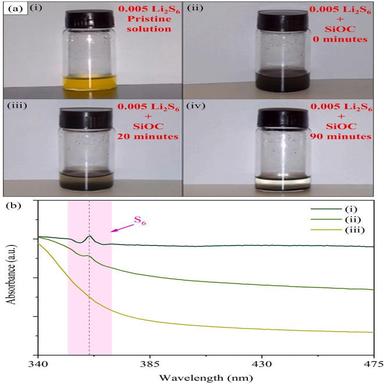
(a) Digital photographs displaying the (i) Li2S6 pristine solution, (ii) immediately after the addition of the SiOC powder, (iii) after 20 min, and (iv) after 90 min. (b) UV–Vis spectrum of (i) 0.005 M Li2S6 dissolved into an electrolyte solution (1 LiTFSI +1 % wt. LiNO3 dissolved into DOL:DME – 1:1); (ii) after 20 min, and (iii) after 90 min of the addition of 70 mg of SiOC in the Li2S6 solution.